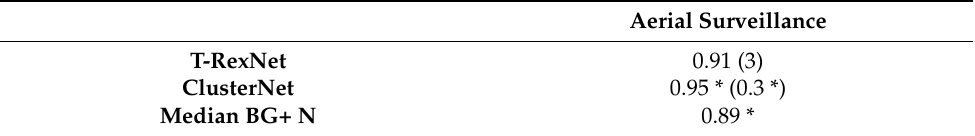
Table 3. Comparison of F1 scores achieved in the Aerial surveillance scenario. Numbers in brackets represent the measured speed, in frames per second, with the Desktop platform. The asterisk indicates that the number is retrieved from the original paper.